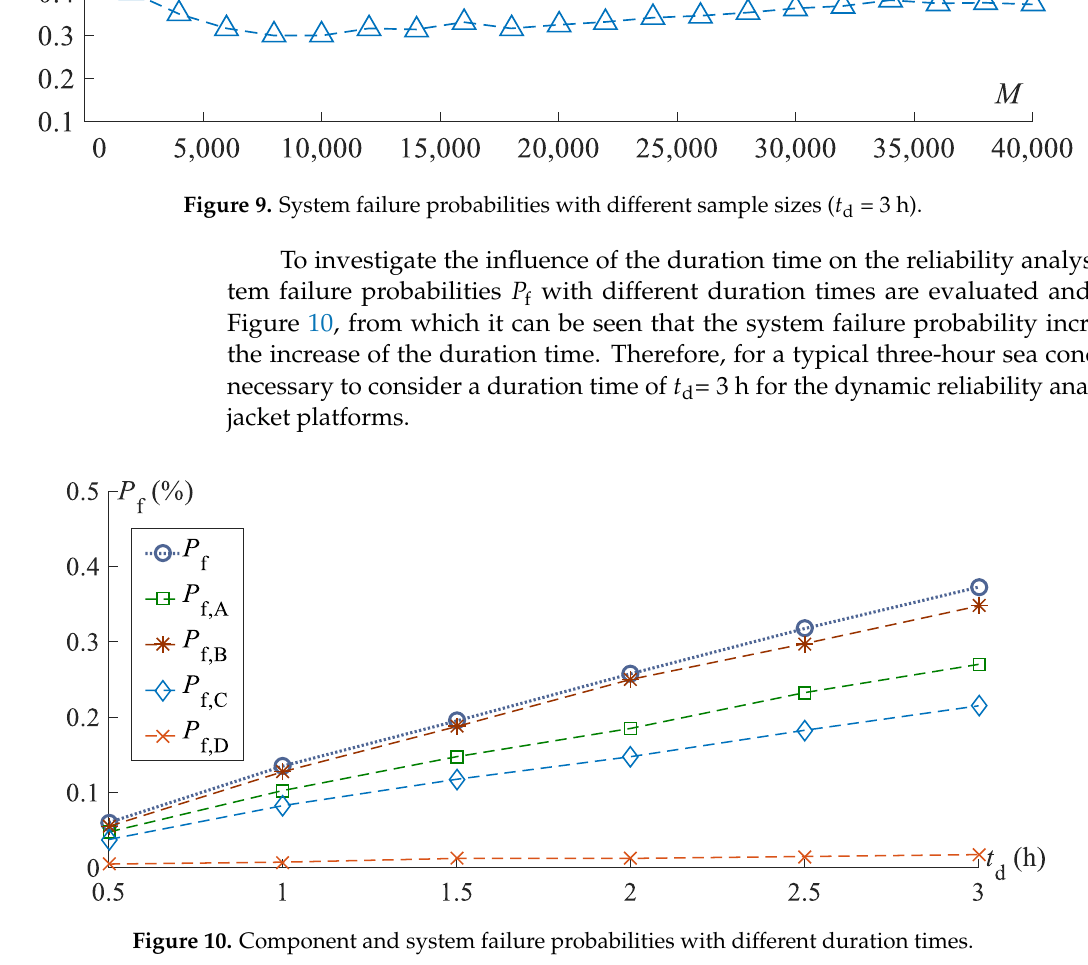
Figure 9. System failure probabilities with different sample sizes (